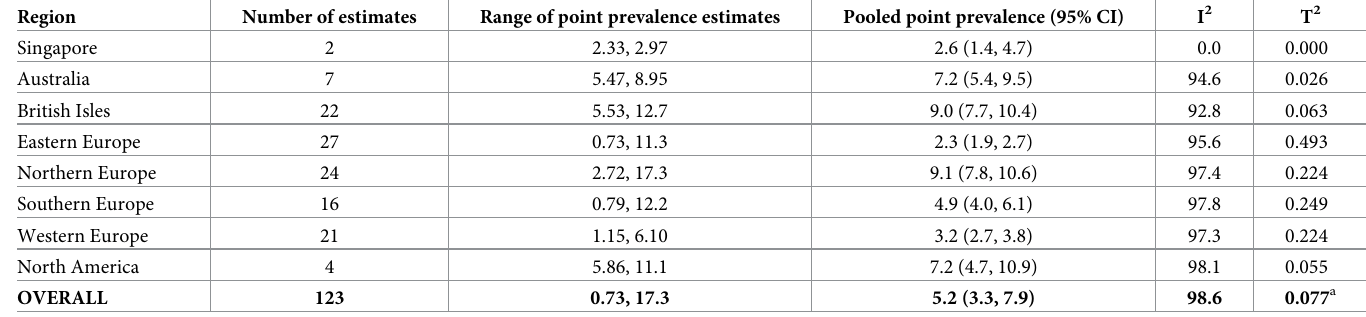
Table 2. Pooled estimates from meta-analysis of point prevalence of antibiotic use by region.